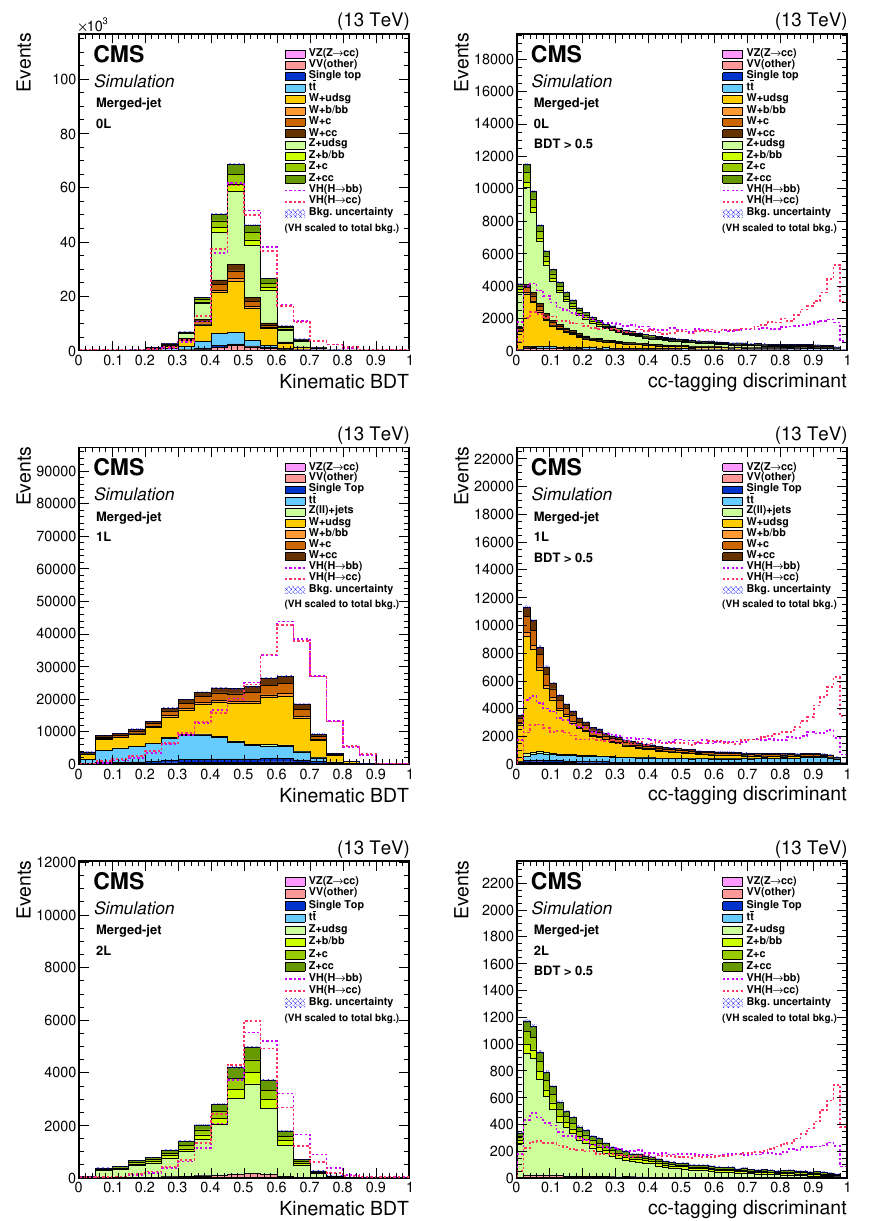
Figure 4 . The VH(H ! cc) signal and background distributions of the kinematic BDT output (left), and the cc discriminant in events with BDT values greater than 0.5 (right), in the 0L (upper), 1L (middle) and 2L (lower) channels. The VH(H ! cc) signal is normalised to the sum of all backgrounds. The VH(H ! bb) contribution, similarly normalised, is also shown.